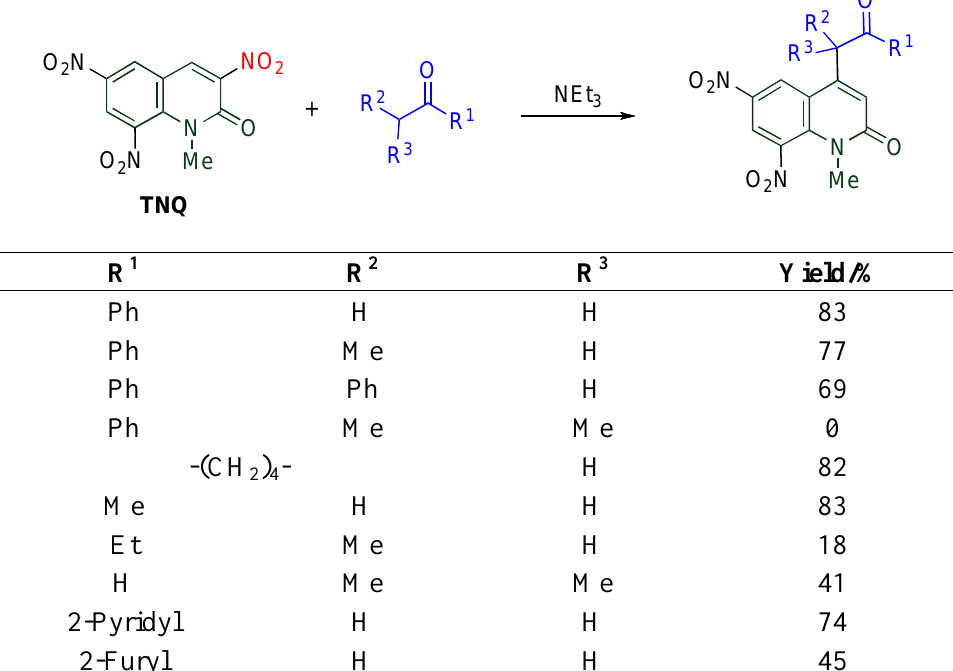
Table 11. Acylmethylation of the MeQone